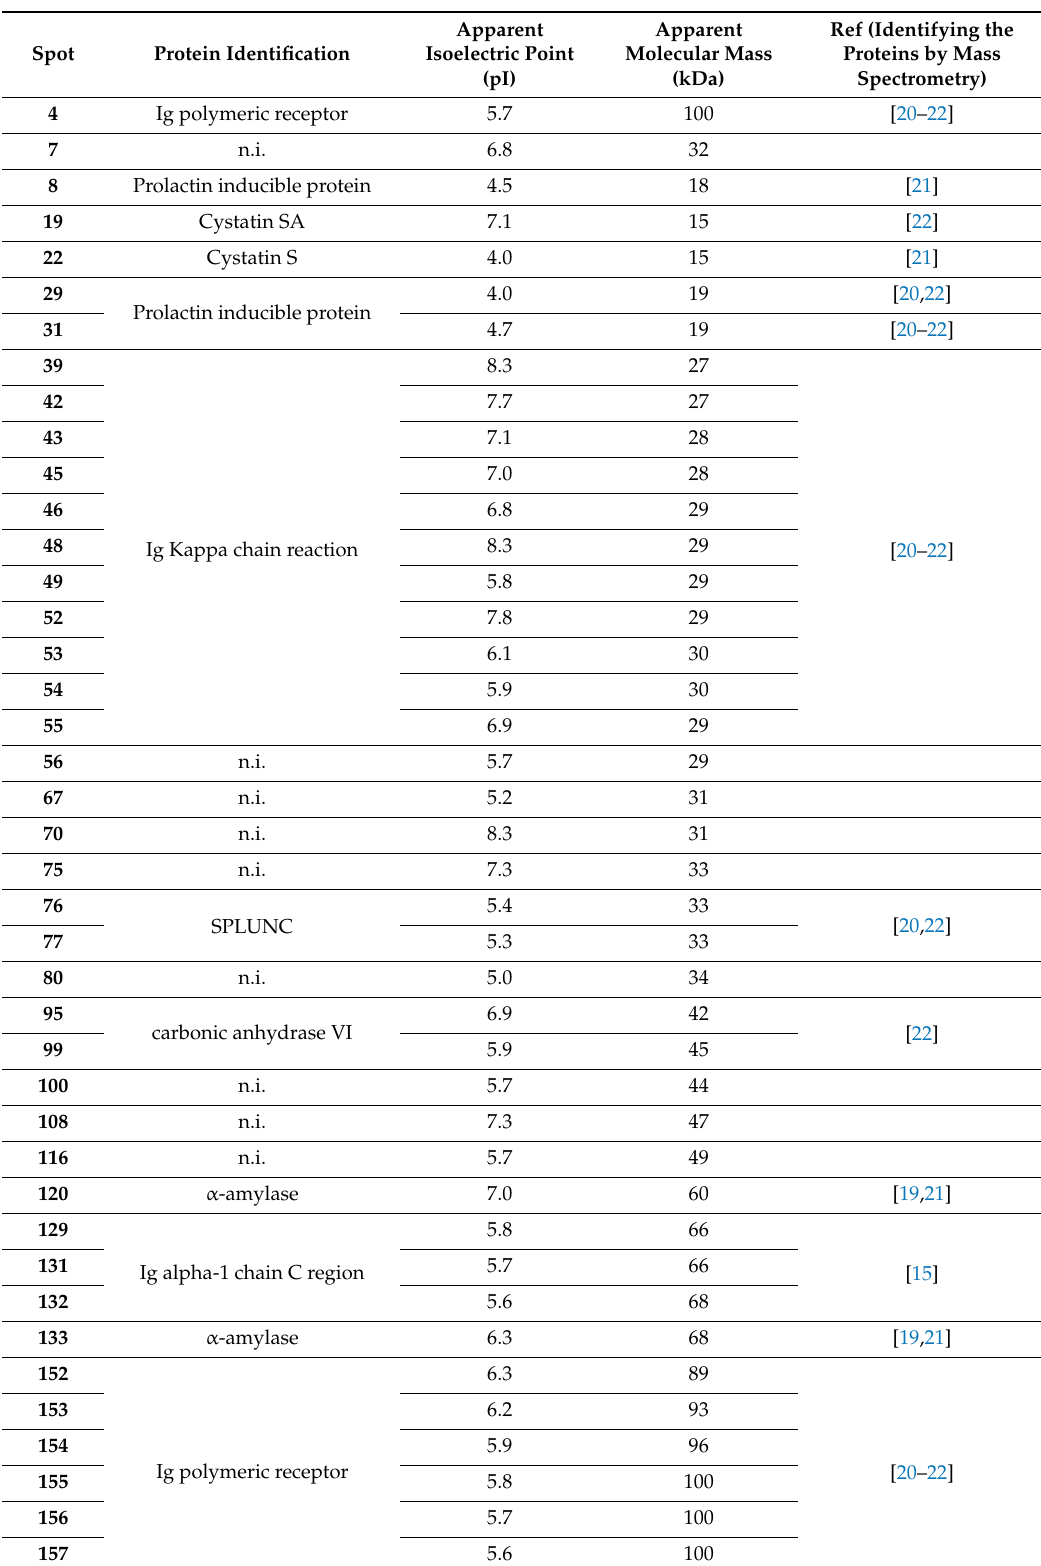
Table 4. Identification and location in the 2-DE profiles of the salivary proteins significantly changed by